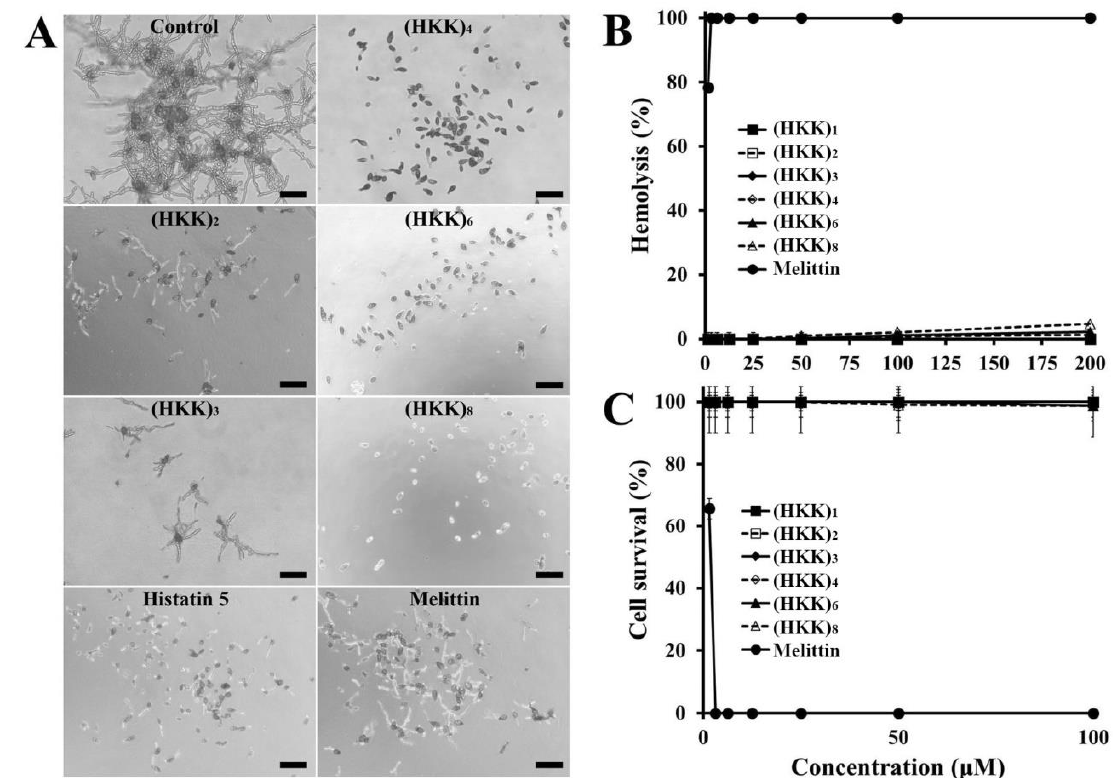
Figure 1. Growth-inhibitory and cytotoxic effects of the peptides. ( A ) After 2 days of incubation with HKK peptides, histatin 5 or melittin, the growth of Fusarium solani cells was visualized under an inverted microscope. Control (untreated), (HKK) 2 (32 µM), (HKK) 3 (16 µM), (HKK) 4 (4 µM), (HKK) 5 (2 µM), (HKK) 6 (1 µM), histatin 5 (32 µM), and melittin (8 µM) samples were evaluated. Bar: 40 µm. ( B ) After 1 h of incubation with the indicated peptides in 8% rat red blood cells (rRBCs), hemoglobin release was measured. ( C ) After 24 h of incubation with the peptides shown in HaCaT cells, cell proliferation was evaluated by MTT assay.